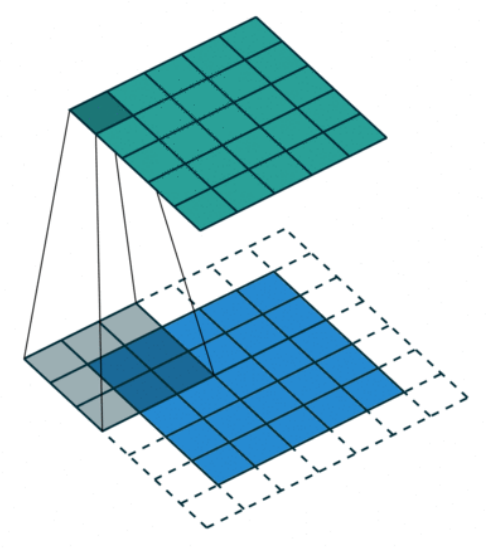
Figure 10. 2D convolution